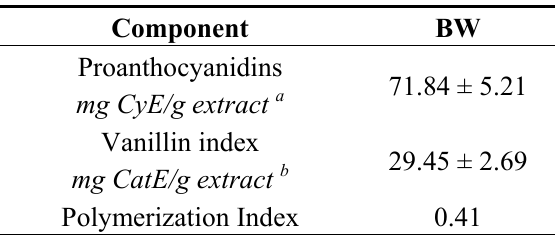
Table 2. Content of proanthocyanidins, flavanols reactive to vanillin (vanillin index) and polymerization index determined in the blanch water (BW) extract. Results are expressed as mean ± SD of three independent determinations.